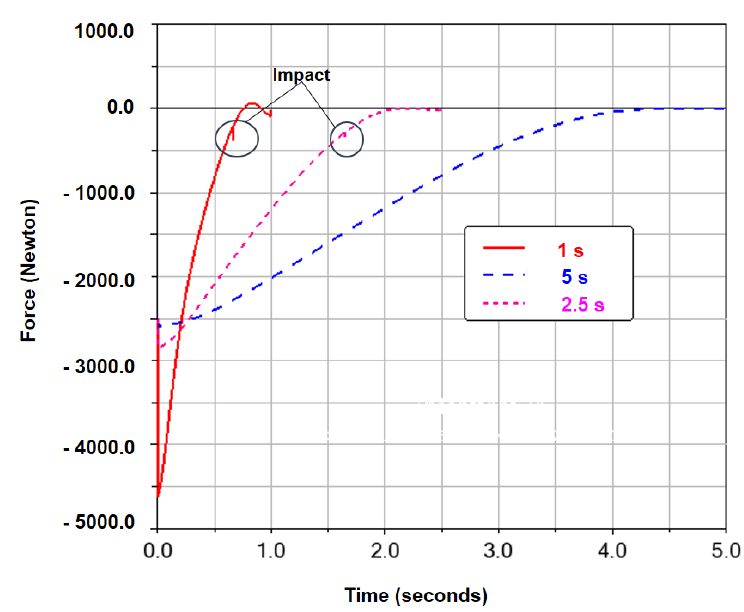
Figure 11. Comparison of the FAS raising force when adopting three raising times (1 s, 2.5 s, and 5 s).